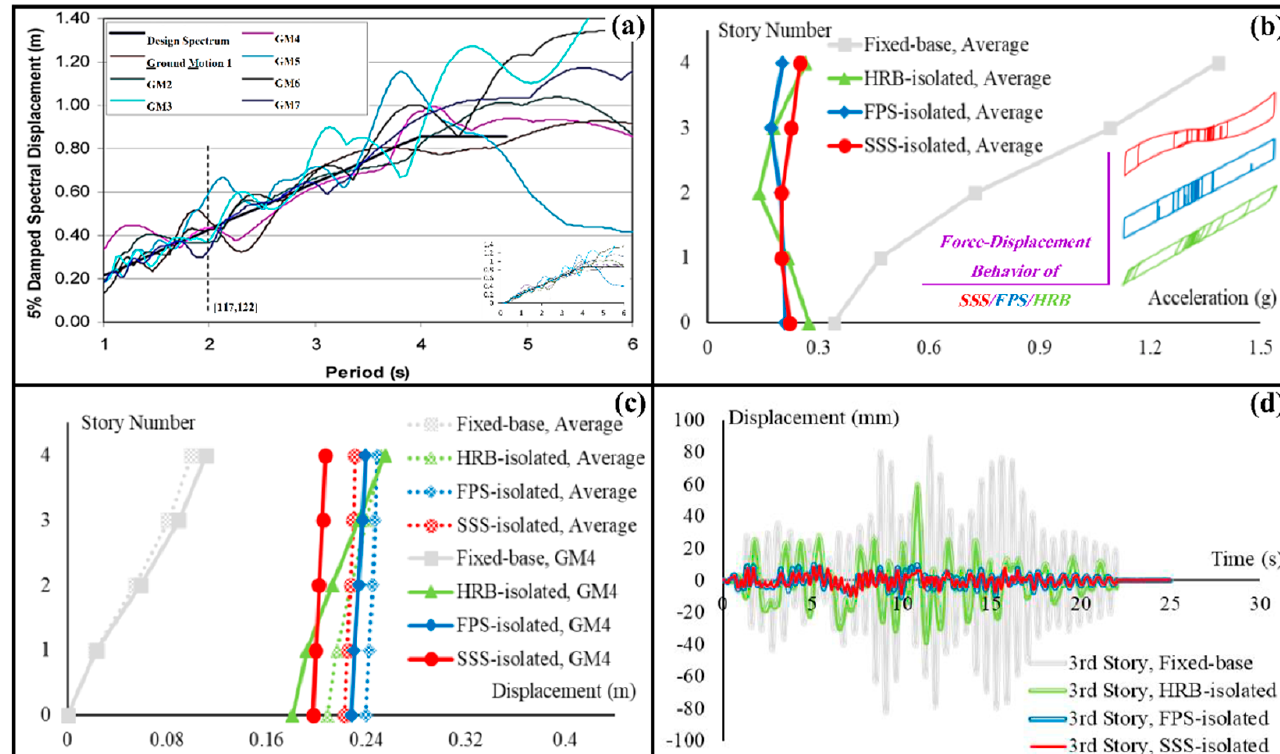
Figure 7. Production of the input for the shaking table experiments: ( a ) response spectra of the ground motion records used in this study, and the reference design spectrum; ( b ) average maximum story accelerations; ( c ) average maximum story displacements and maximum story displacements under the selected ground motion record; and ( d ) the input excitations produced for the experi ‐ ments.